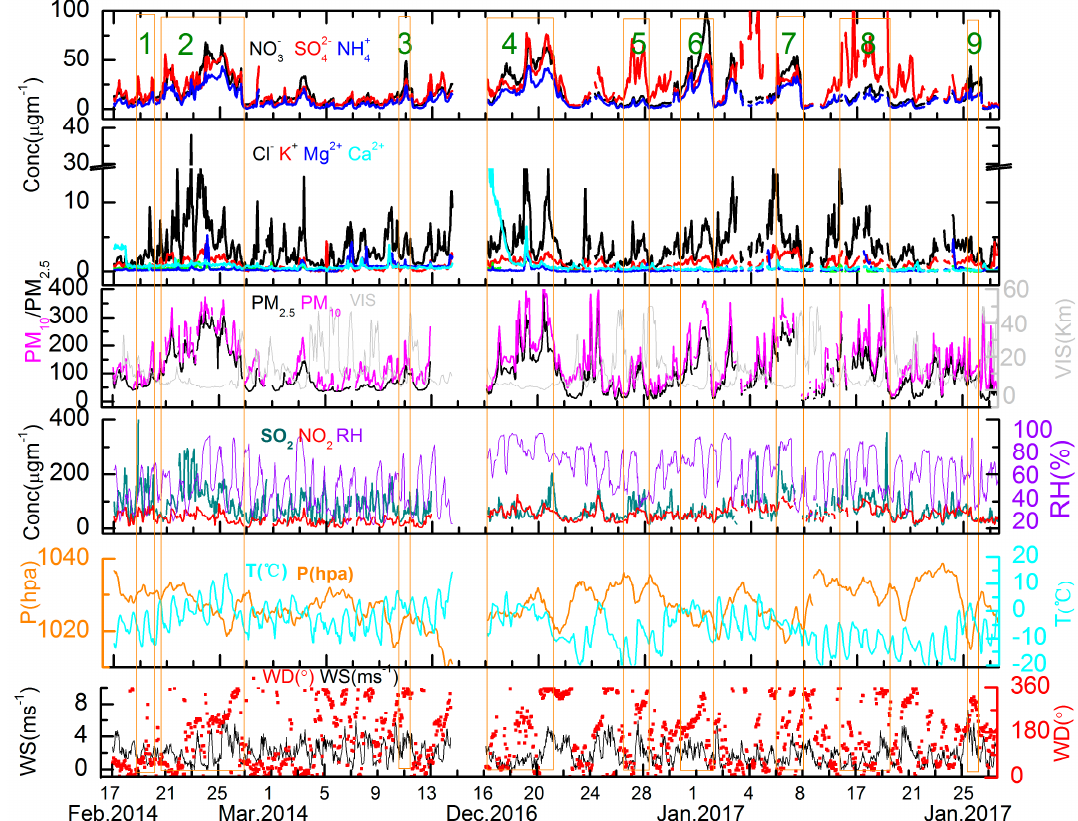
Figure 3. Time series of hourly concentrations ( µ g · m − 3 ) of TWSIs (include SO 42 − , NO 3 − , NH 4+ , Cl − , K + , Mg 2+ , and Ca 2+ ) of PM 10 , PM 2.5 , gaseous SO 2 and NO 2 , atmospheric visibility (Vis, km), relative humidity (RH, %), pressure (P, hpa), temperature (T, ◦ C), wind direction (WD, ◦ ), and wind speed (WS, m · s − 1 ), measured over the ambient observation period. Hatched frames refer to the identified haze pollution episodes.